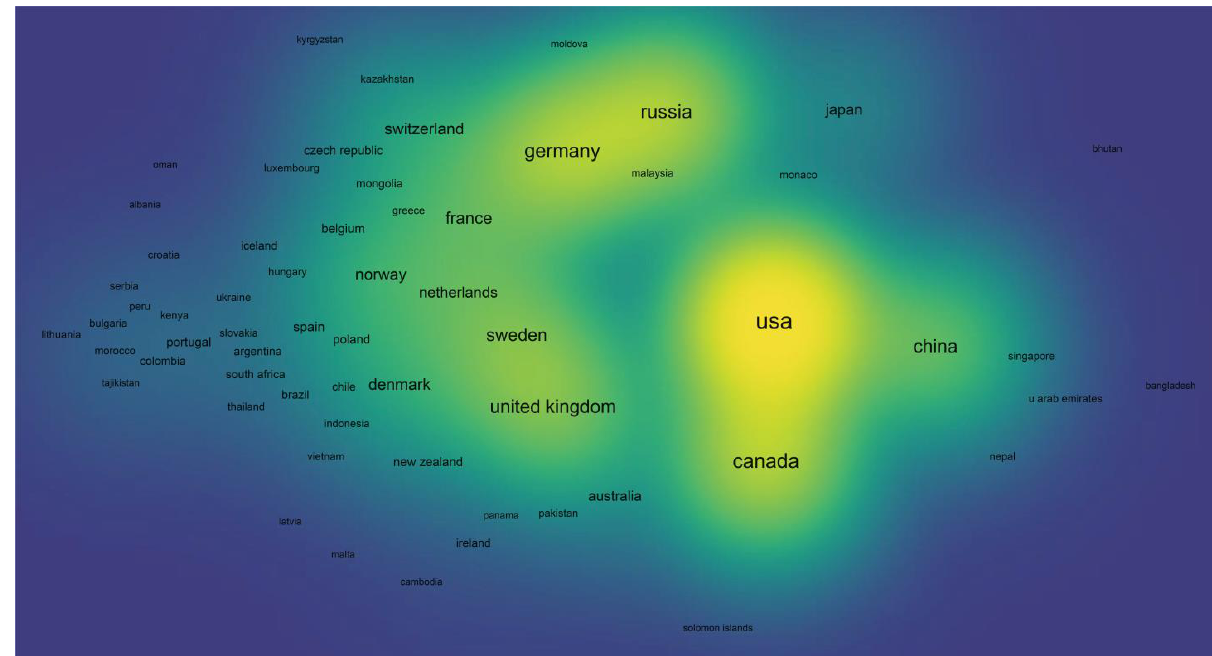
Figure 7. Cooperation density map on permafrost research regarding countries.